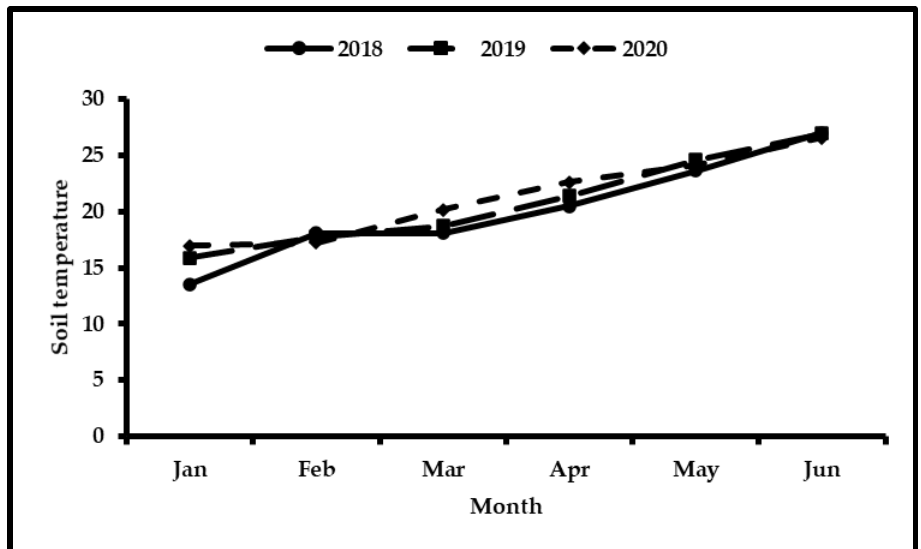
Figure 2. Soil temperature at potato growing season from January to June for the years 2018, 2019, and 2020.